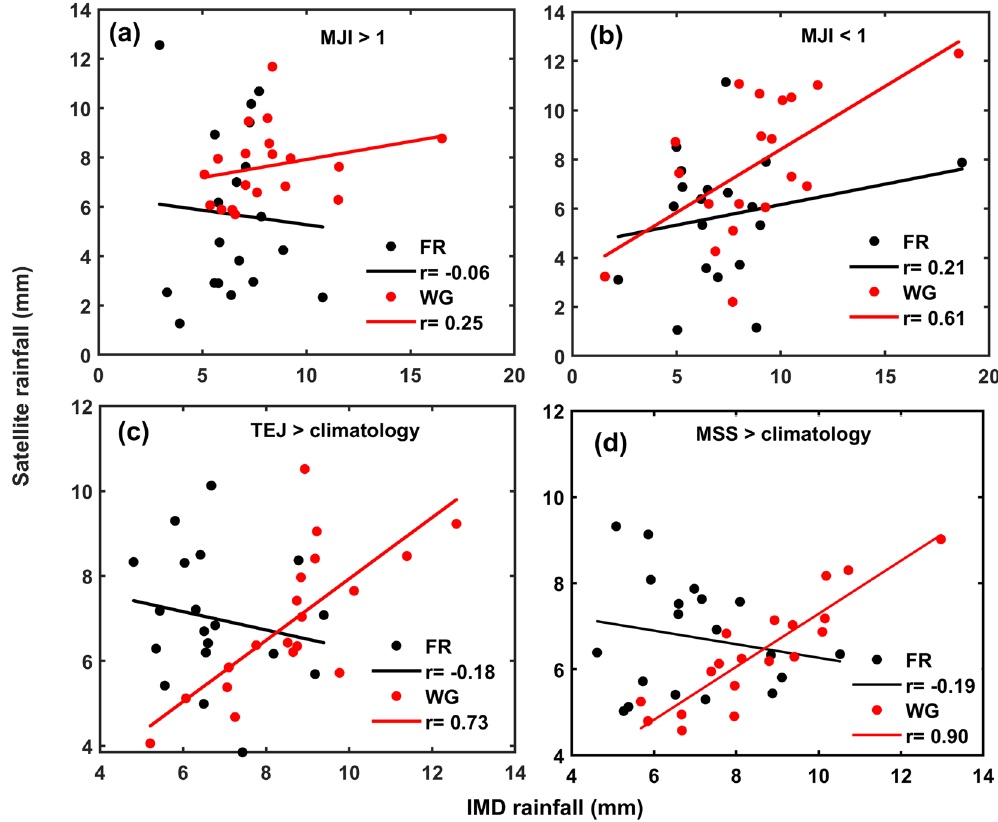
Figure 4. Scatter plot IMD rainfall and Satellite rainfall when ( a ) MJI > 1 ( b ) MJI < 1 ( c ) TEJ > climatology ( d ) MSS > climatology value over FR and